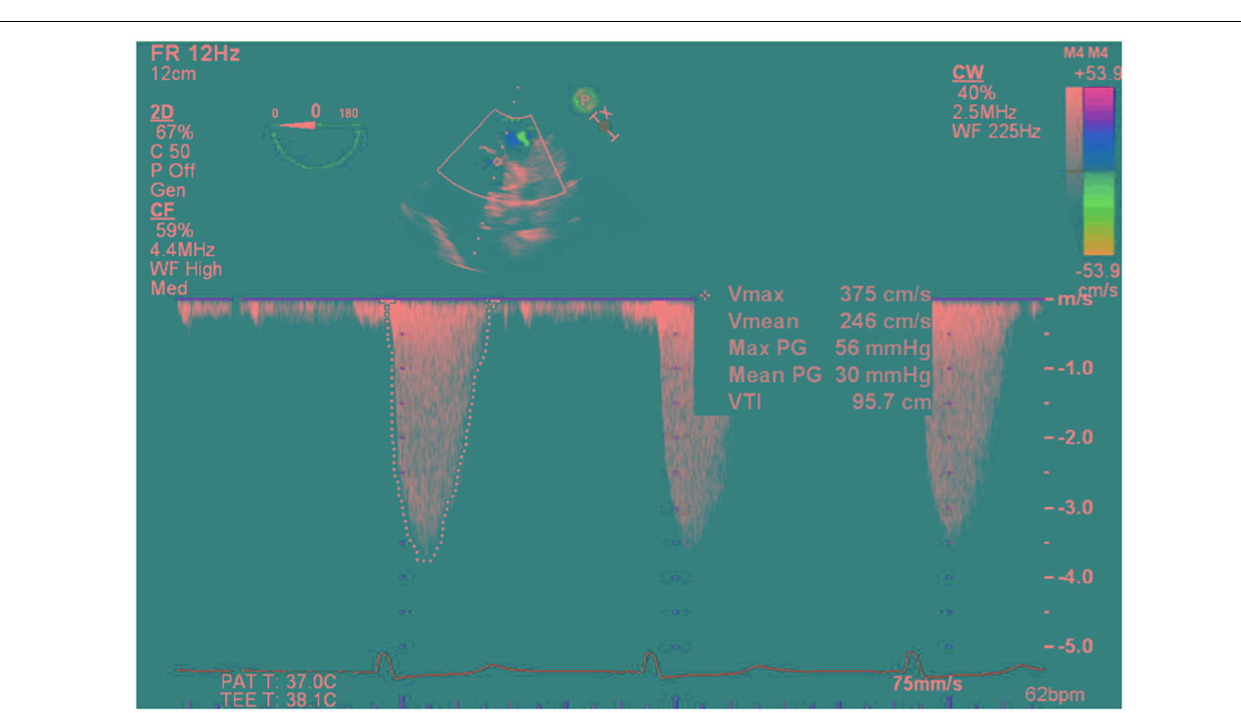
cardiovascularintensivecareunit,whereshewasextubated7hours later and discharged home on postoperative day